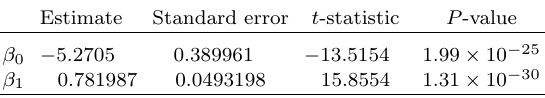
Table A.6. Regression results for model A.15.